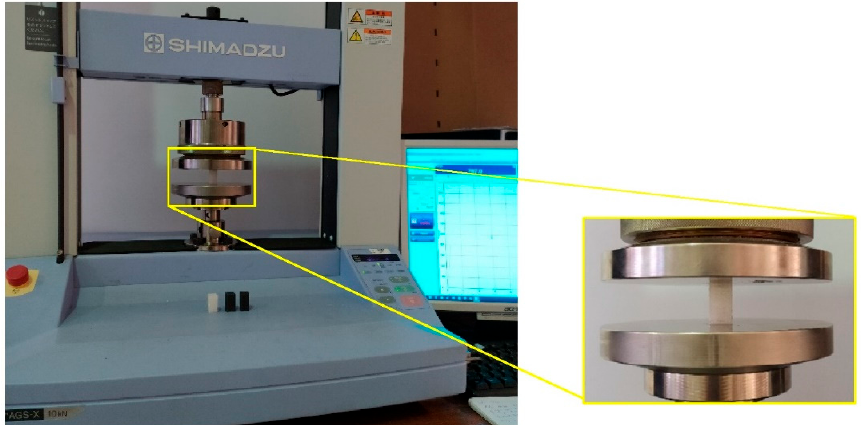
Figure 2. Compression test setup.